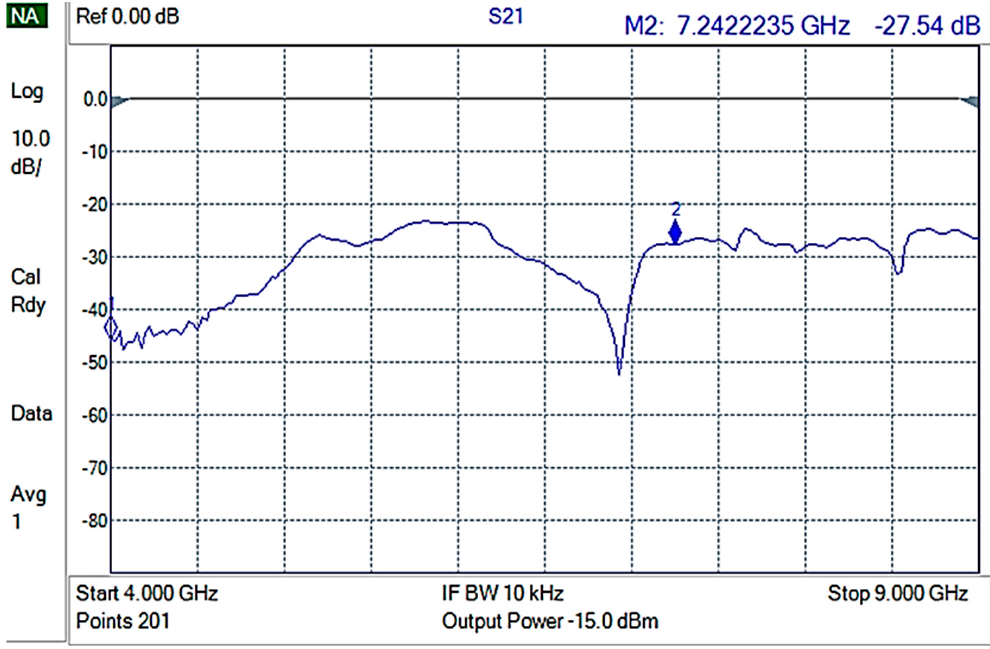
Figure 8. S21 for GNPV containing composite materials.